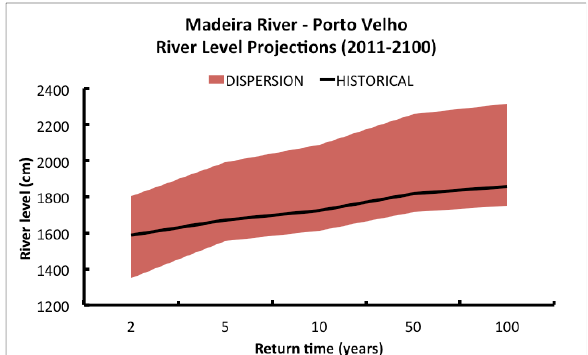
Figure 2: Dispersion of the maximum river levels estimated for different return times using hydrological simulation based on several climate models projections (2011-2100).